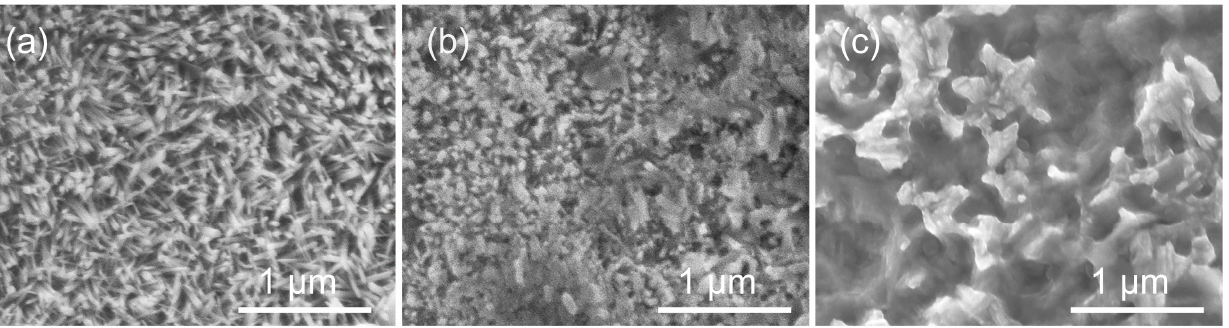
Figure 5. SEM of electrodeposited zinc film: ( a – c ) are under 50 Hz, 100 Hz, and 1000 Hz, respectively.